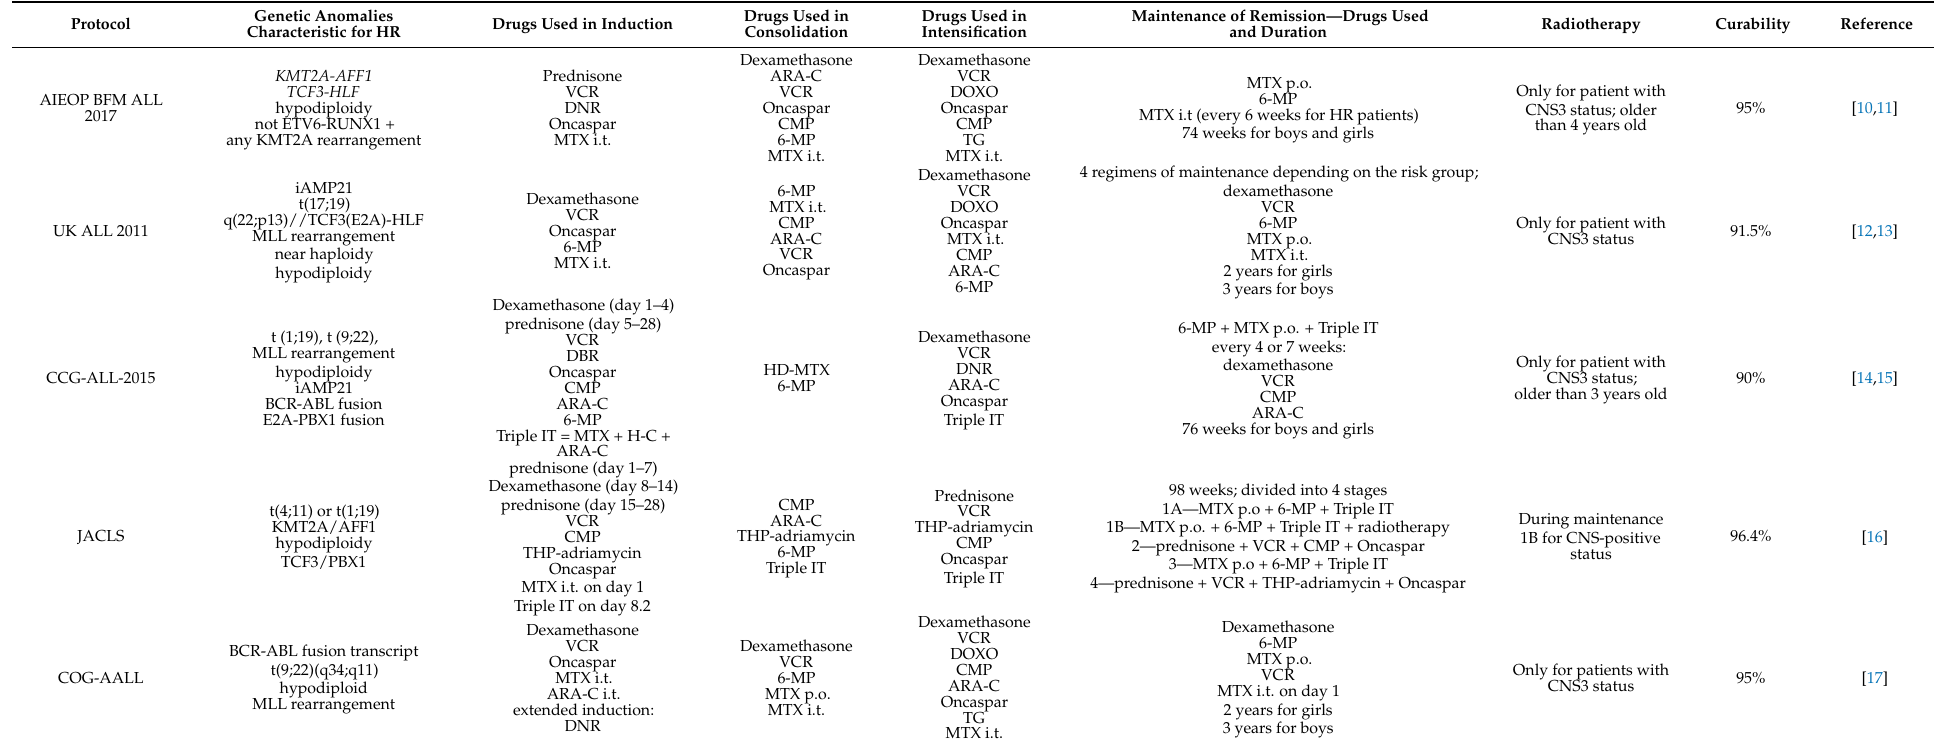
Comparison of protocols used in ALL treatment. AIEOP BFM ALL 2017—International collaborative treatment protocol for children and adolescents with acute lymphoblastic leukemia, UK ALL 2011—United Kingdom National Randomised Trial For Children and Young Adults with Acute Lymphoblastic Leukaemia and Lymphoma 2011,